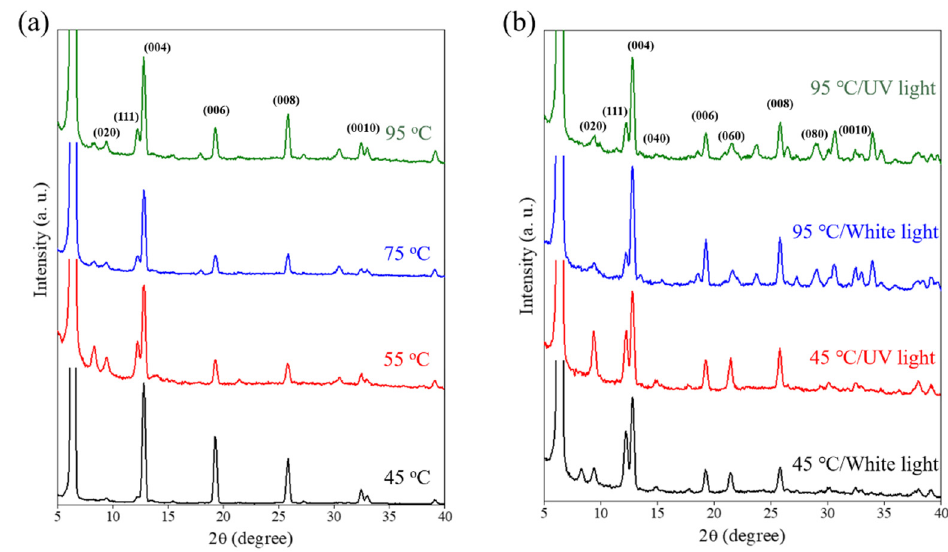
Figure 6. XRD of (C 4 H 9 NH 3 ) 2 PbBr 4 2D perovskite fabricated by a dip-coating method under ( a ) different heating temperatures and ( b ) different light exposure conditions.